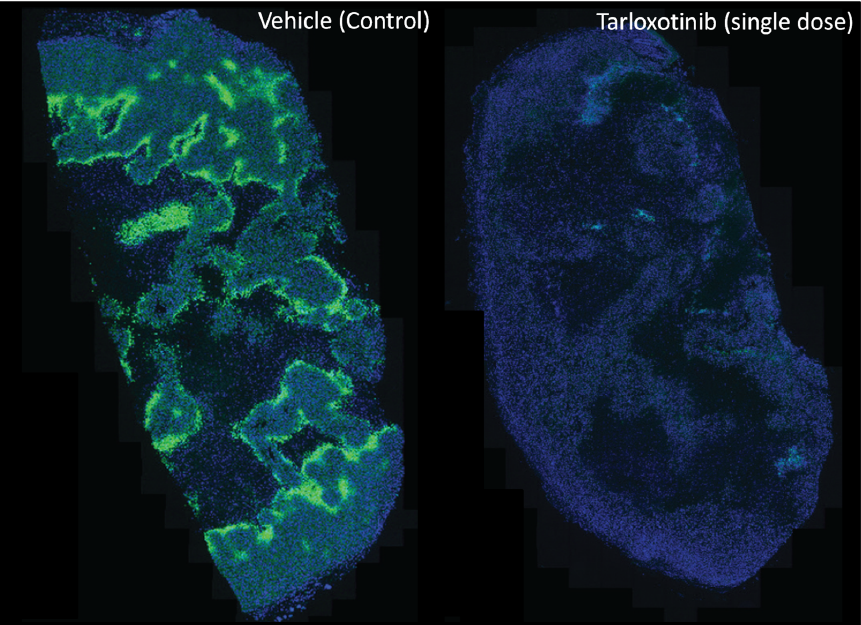
Figure 4. Modification of the hypoxic microenvironment following administration of tarloxotinib in PC9 mutant-EGFR NSCLC tumour-bearing mice. The representative immunohistochemical image shows hypoxic regions (green, pimonidazole binding) across a tumour cross section before and after (72 h) a single dose of tarloxotinib (30 mg/kg, intraperitoneal). Nuclei are counterstained (blue, DAPI). Image was provided by Dr Shevan Silva with permission.